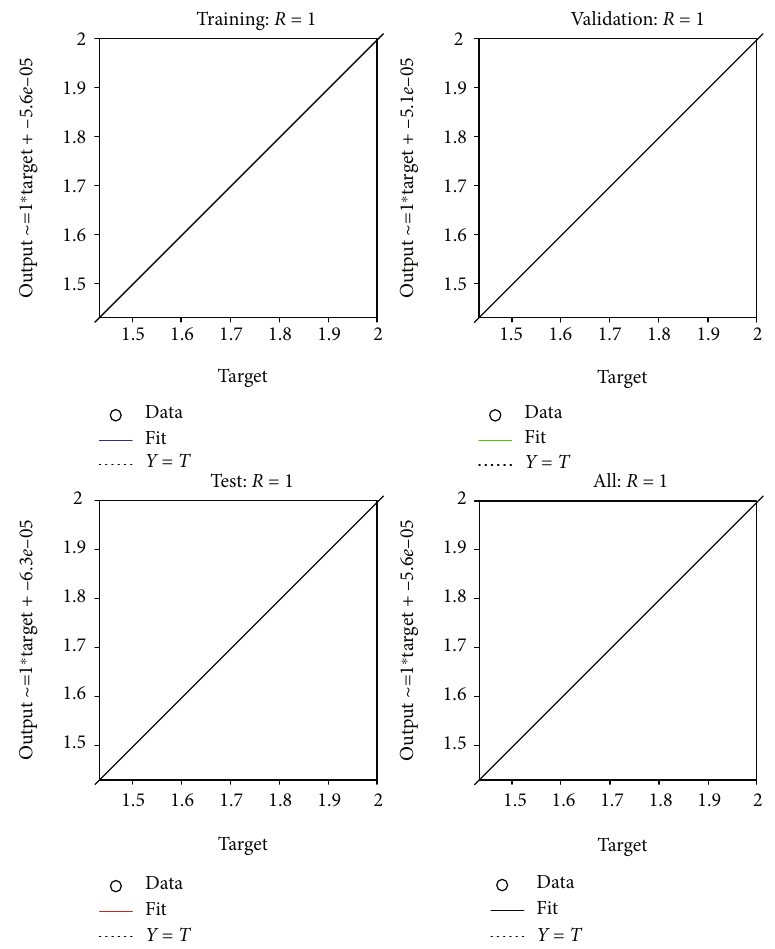
Figure 28: DNN-based current regulator — training, test, and validation.